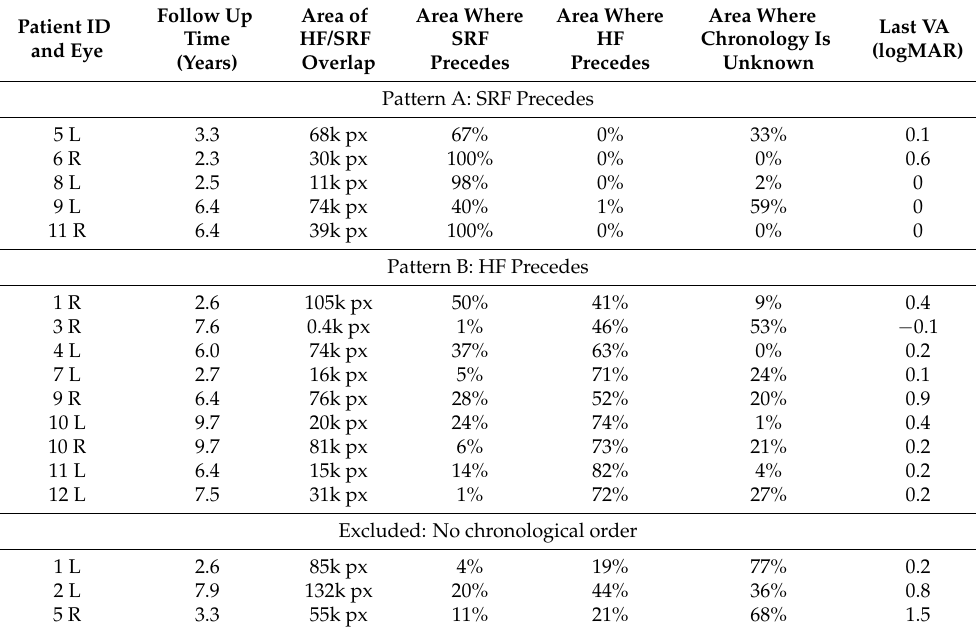
Table 3. Temporal analysis of the relationship of SRF and HF progression. VA is visual acuity development measured in logMAR, meaning a smaller value is a higher VA. According visualisations are given in Figures A1–A3. Follow Up Area of Area Where Area Where Area Where Patient ID Time HF/SRF SRF HF Chronology and Eye (Years) Overlap Precedes